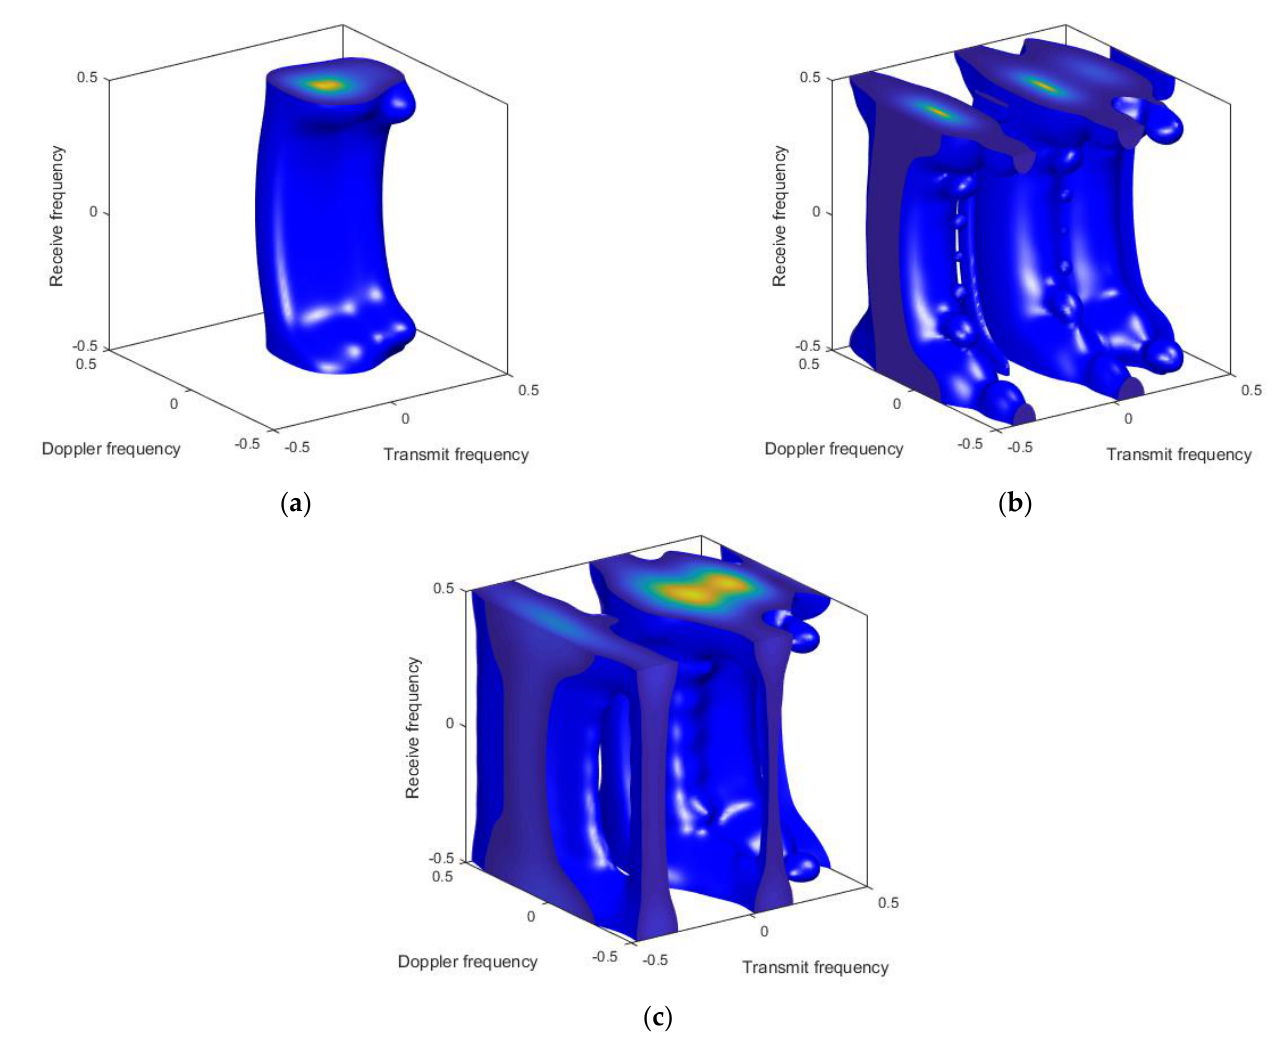
Figure 11. dB range ambiguous clutter power spectrum. ( a ) MIMO; ( b ) FDA; ( c ) MLC FDA.